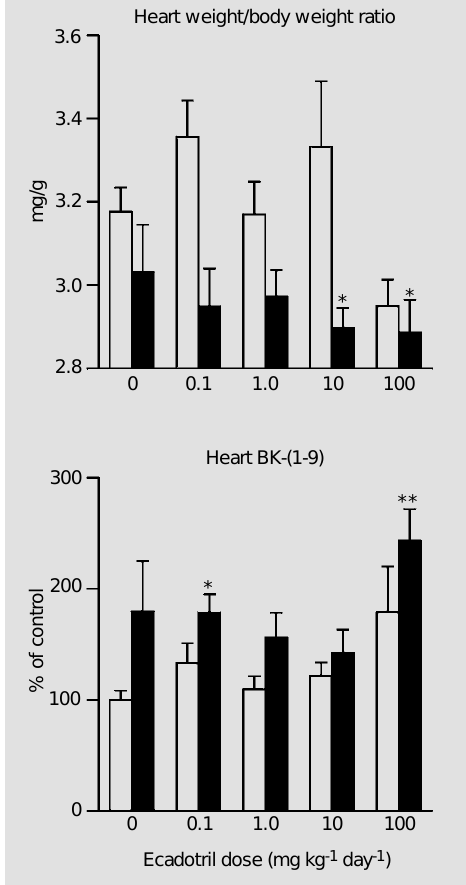
)Figure 6 - Effects of ecadotril ad- ministration alone (open col- umns) and together with 0.2 mg kg -1 day -1 perindopril (closed col- umns) on the heart weight/body weight ratio (upper panel) and heart BK-(1-9) levels (lower panel) in rats with myocardial in- farction. Each value represents the mean ± SEM. *P<0.05, **P<0.01 in comparison with ve- hicle-treated control, N = 9-10 rats per group. (Redrawn from Ref.